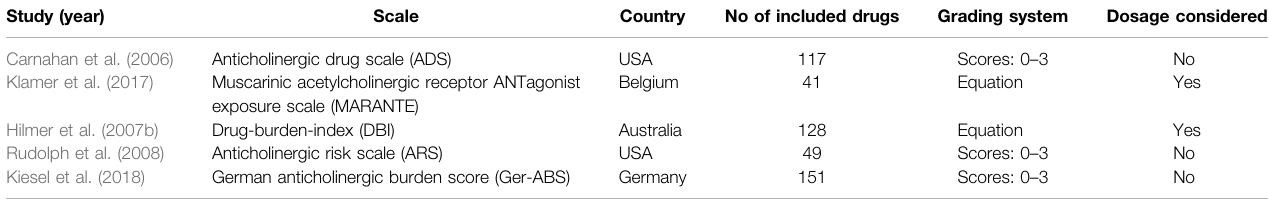
TABLE 3 | Overview of anticholinergic scales ’ characteristics.